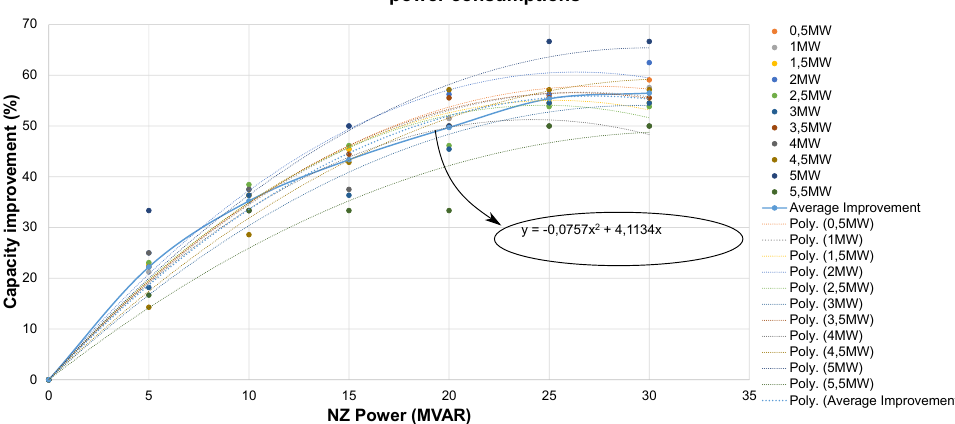
Figure 15. Relation of capacity improvement with the increase of the NZ reactive power. The dots display the Table 2 percentage improvement values; the smaller dot lines present polynomial regression curves from each of those points. The blue dash-dot line (Average improvement) presents a polynomial regression curve from the average of all the improvement